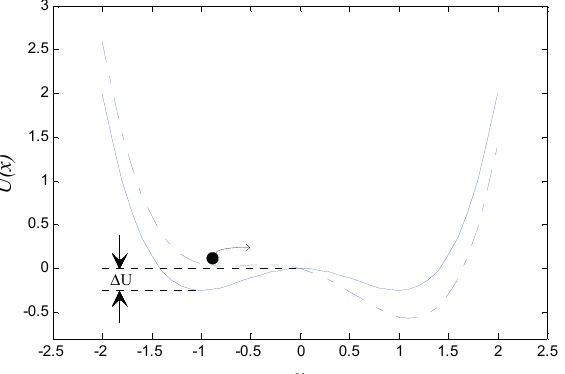
Figure 1. Bistable potential function of the Duffing system without driving force (solid line) and potential changes with driving force (dotted line). Switching events may take place in the presence of noise as indicated by the